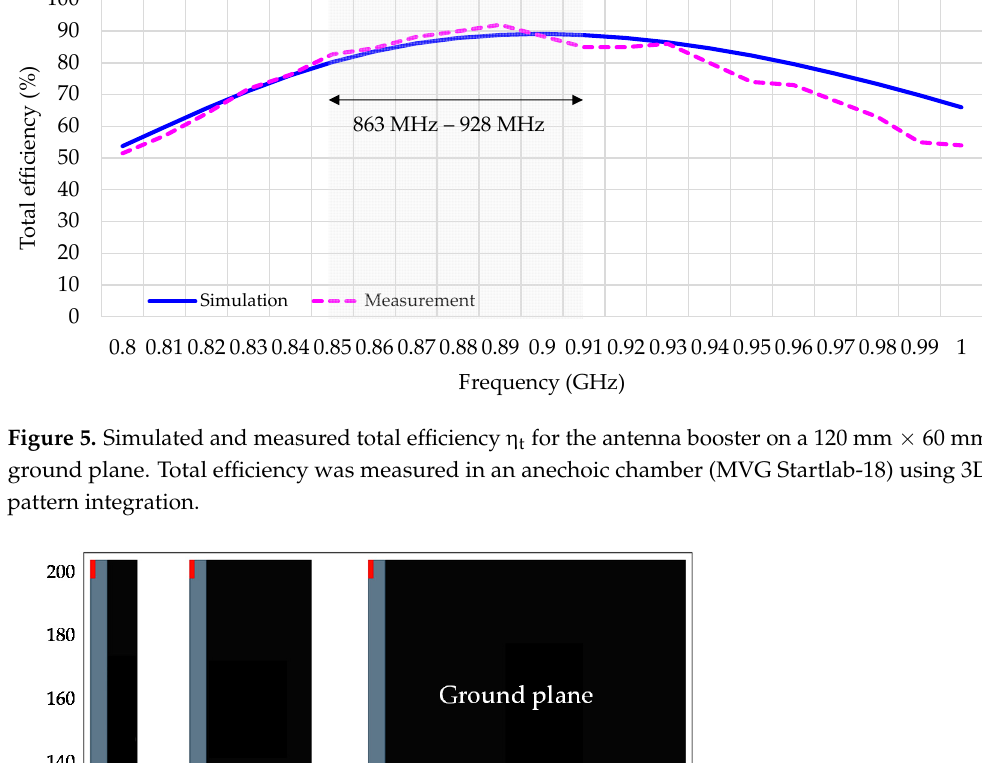
Figure 5. Simulated and measured total efficiency η t for the antenna booster on a 120 mm × 60 mm ground plane. Total efficiency was measured in an anechoic chamber (MVG Startlab-18) using 3D pattern integration.